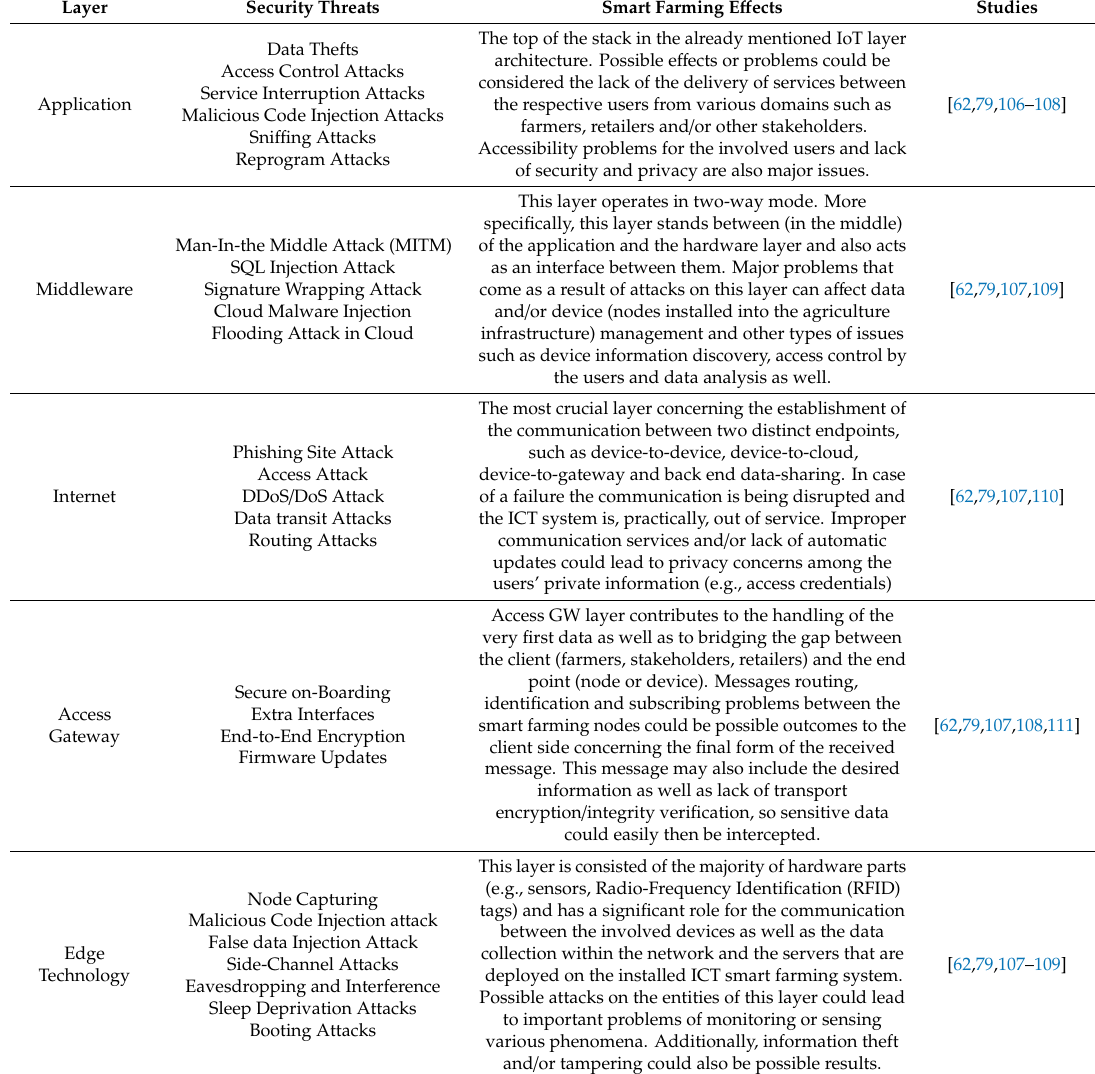
Table 3. Overview of security threats in agriculture across di ff erent IoT